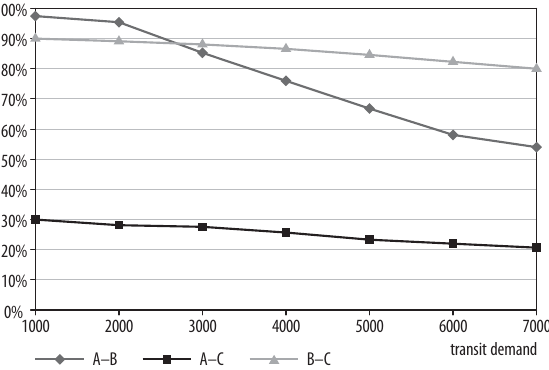
Fig. 3. Th e percentage of passengers using train with diff erent levels of transit